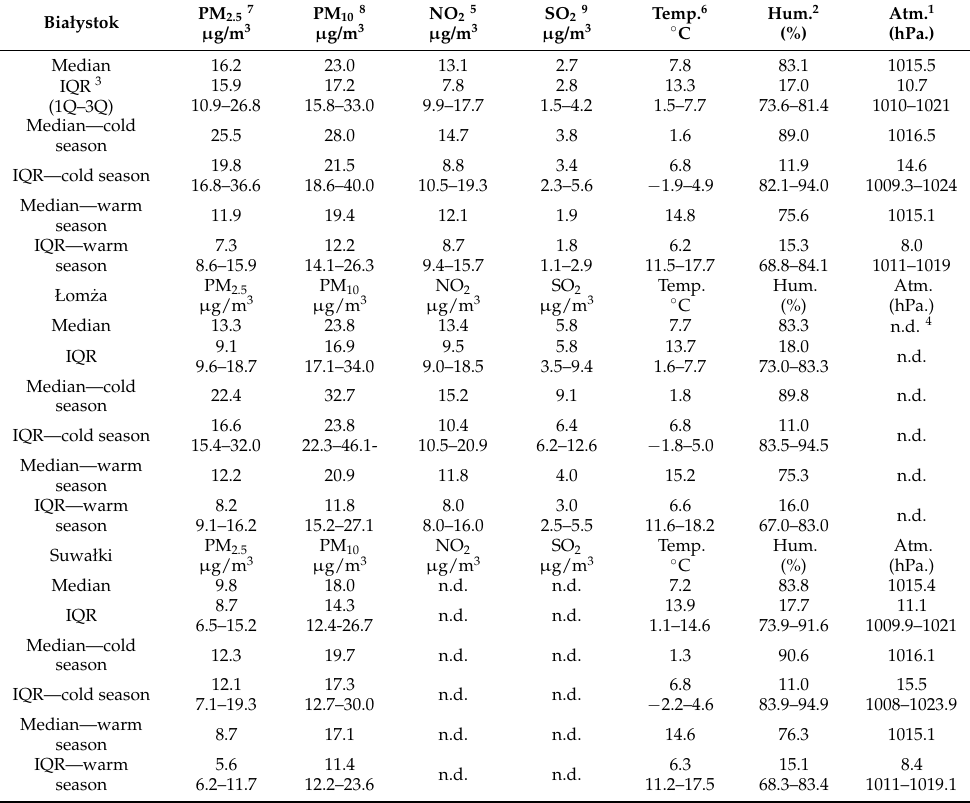
Table 2. Statistics for the 24-h (midnight to midnight) concentrations of air pollutants and weather conditions in the studied